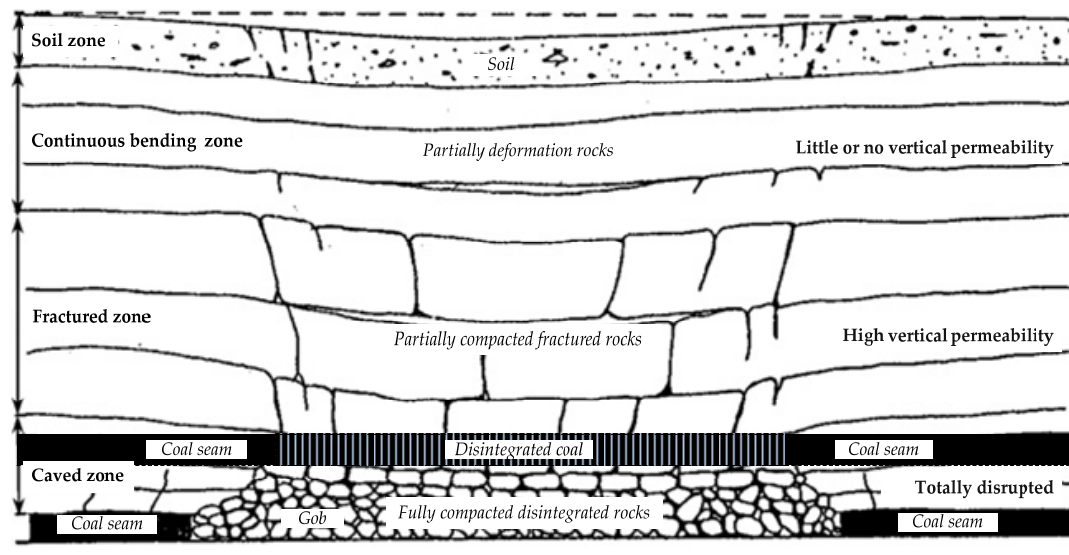
Figure 3. Four zones of overlying strata above a longwall panel [42].